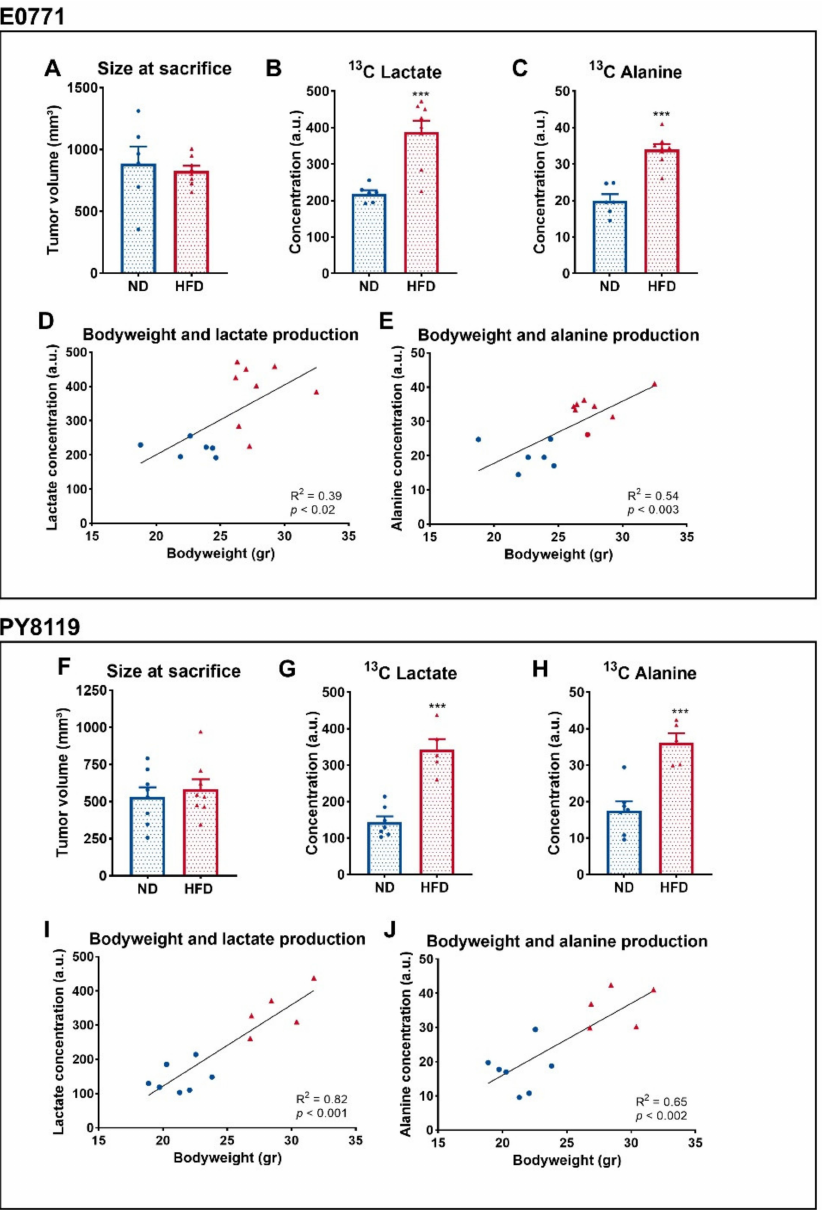
Figure 3. Breast tumors of obese mice produce more lactate than tumors of lean mice. ( A – E ): E0771 cell line; sample size: n = 6 for ND and n = 8 for HFD. ( F – J ): PY8119 cell line; sample size: n = 7 for ND and n = 5 for HFD. ( A , F ) Tumor size at the time of the necropsy. ( B , G ) 13 C lactate and ( C , H ) 13 C alanine concentrations from tumor extracts. ( D , I ) Correlation curve between the bodyweight of the mice and tumor 13 C lactate ( E ) and 13 C alanine ( F , J ) production. Statistical analysis: unpaired t -test; *** p <